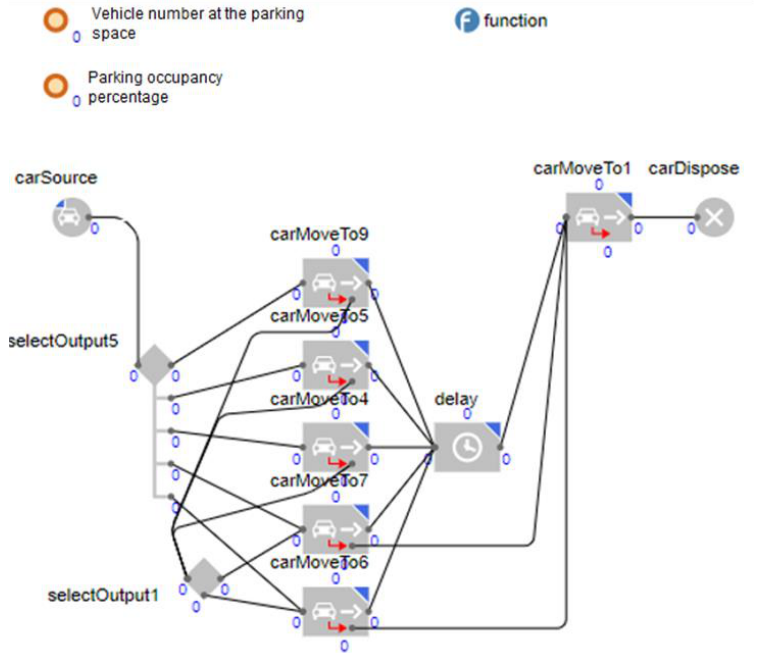
Figure 8. Process diagram of the new model. Infrastructures 2022 , 7 , 140